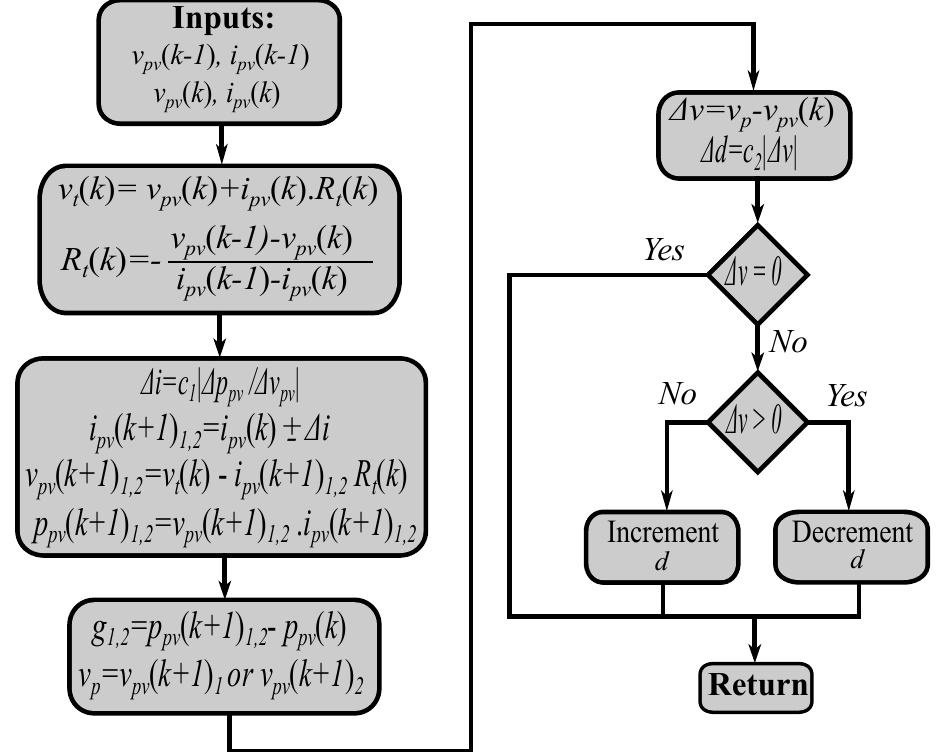
Figure 6. The flowchart of the proposed predictive MPPT